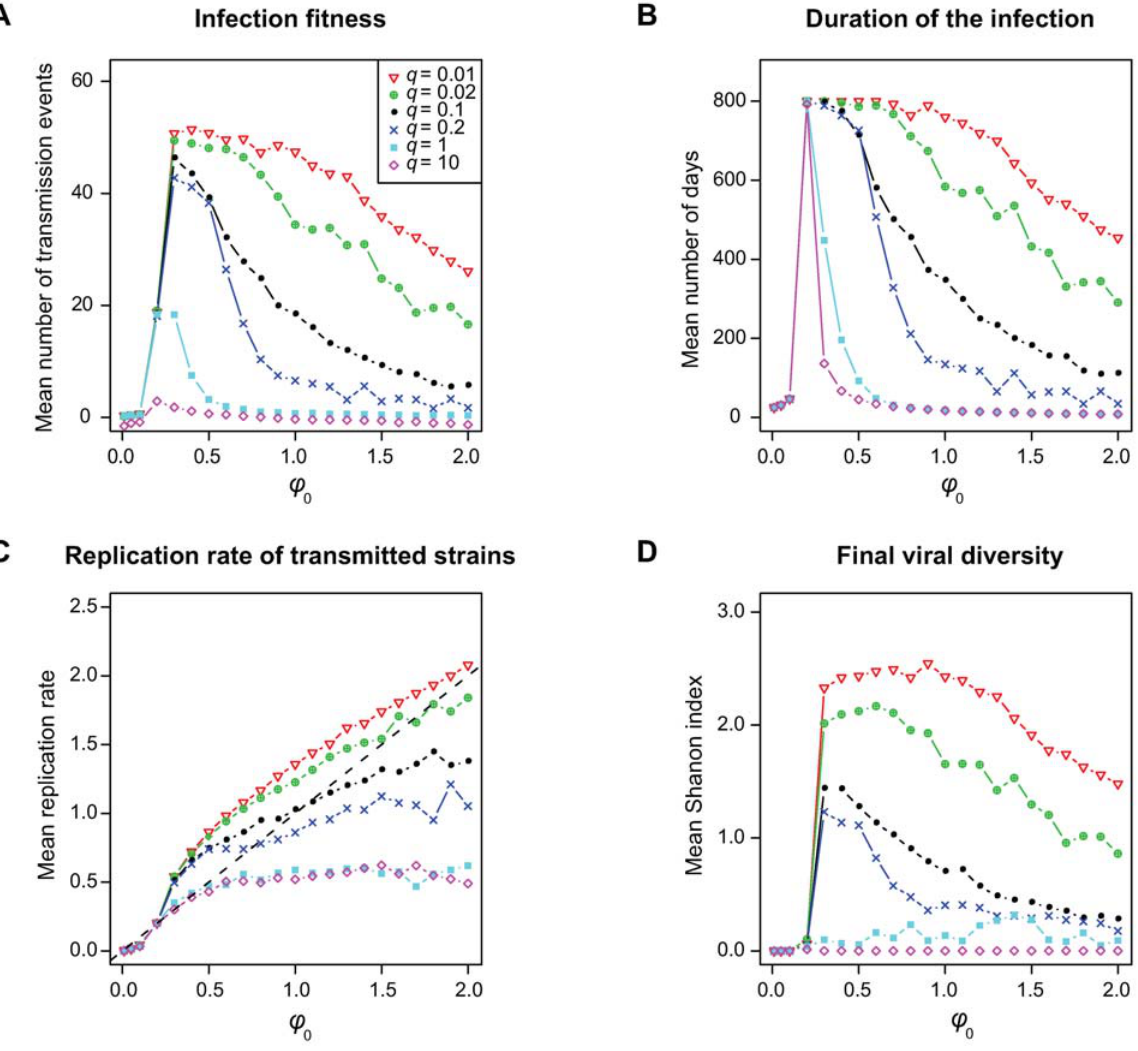
Figure 2. Effect of the variation of the initial replication rate ( QQ 0 ) and of the breadth of cross-reactive immunity ( q ) on infection life- history traits. A) Number of transmission events (i.e. infection fitness), B) Duration of the infection, C) Average replication rate of transmitted strains, and D) Viral diversity (Shannon index) near the end of the infection. Curves with different colour symbols represent simulations performed with different values of q (see the box in panel A). The case with default parameter values is shown with black filled circles. For further details about the simulations see the main text and Text S1.